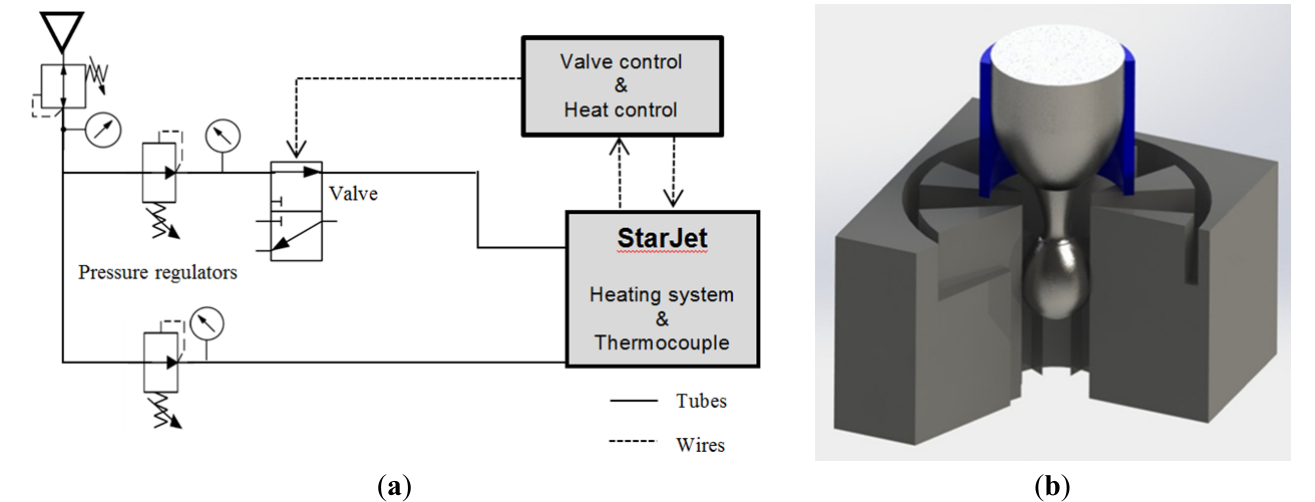
Figure 1. ( a ) Schematic drawing of the StarJet system. ( b ) Model drawing of a metal droplet inside entering the star-shaped nozzle chip (grey); the reservoir outlet is represented by the blue